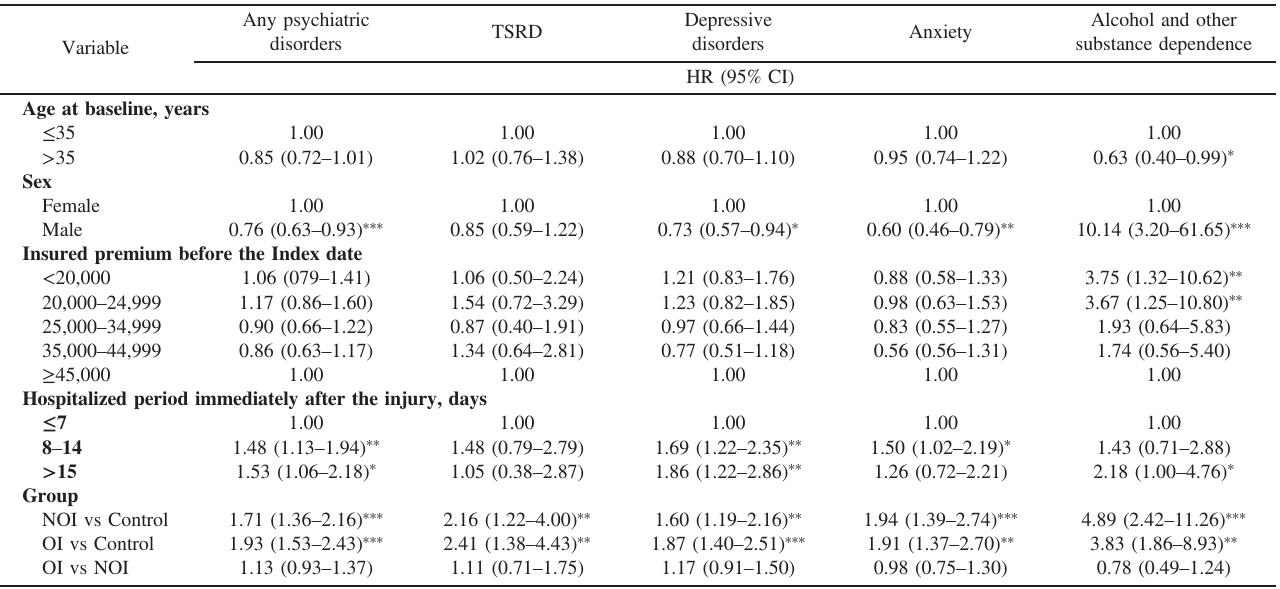
Table 2. Crude hazard ratios of psychiatric disorders in the univariate models using Cox regression